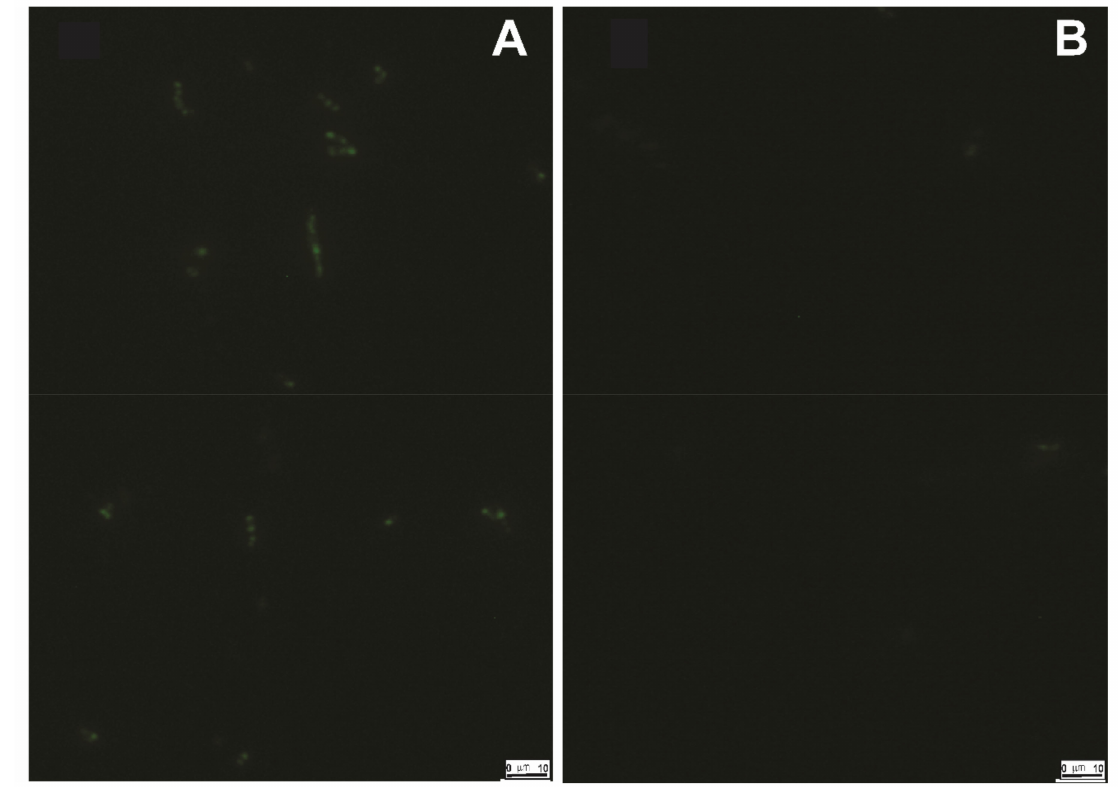
Figure 10. Fluorescence microscopy images of recombinant E. coli cells expressing Aea ABC-TMOF receptor ( A ) and E. coli cells with an empty pTAC-MAT-2 plasmid ( B ). E. coli cells (10 8 cells) were incubated with Aea TMOF-FITC overnight in M8 medium at 37 ◦ C. After incubation, the cells were washed 3X and observed by fluorescence microscopy. E. coli cell expressing the Aea ABC-TMOF receptor highly fluoresce ( A ) whereas bacterial cells not expressing the Aea ABC-TMOF receptor barely fluoresce ( B ). Bars are equal to 10 µ m.